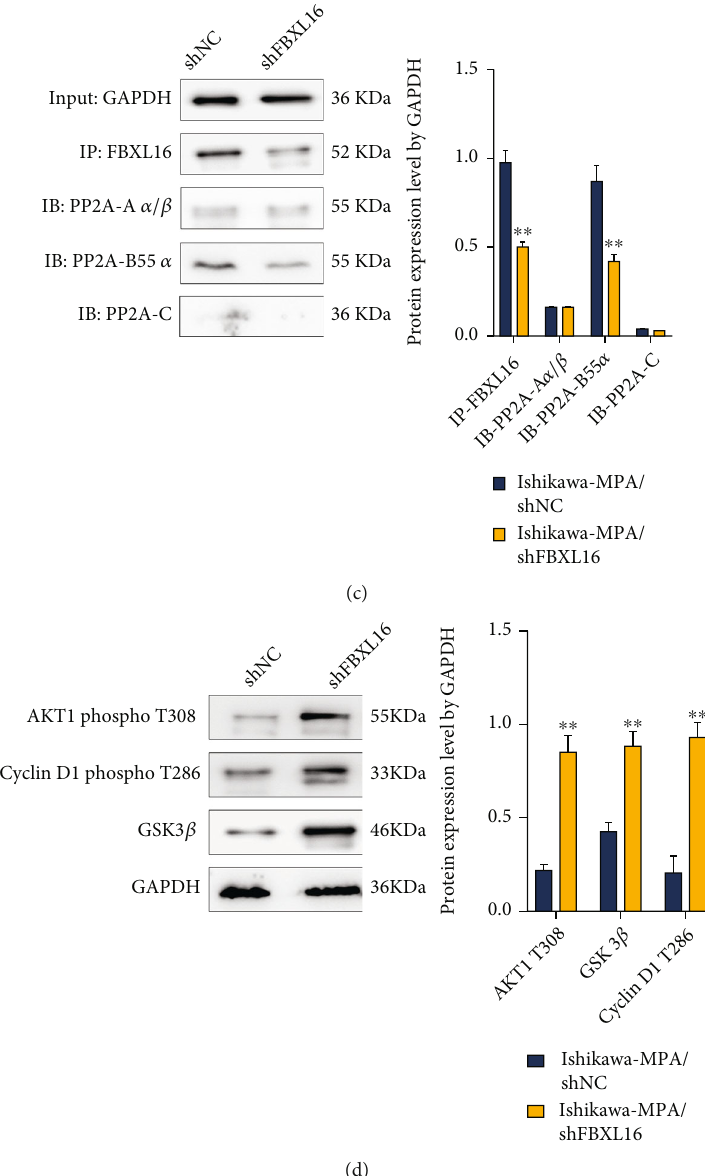
Figure 4: FBXL16 dephosphorylated cyclin D1 by regulating Akt1/GSK-3 β signaling pathway via binding PP2A B55 α . (a) Western blot analyses of cyclin D1 and phosphor-cyclin D1 (T286) in Ishikawa/MPA with shNC and shFBXL16 cells. (b) Coimmunoprecipitation of E3 ligase and cyclin D1 in Ishikawa/MPA cells with the shRNA-NC or shFBXL16 group. (c) Coimmunoprecipitation of FBXL16, PP2A-A α / β , PP2A-B55 α , and PP2A-C in Ishikawa/MPA cells with the shRNA-NC or shFBXL16 group. (d) Western blot analyses of phosphor-cyclin D1 (T286) and GSK3 β /AKT1 pathway in Ishikawa/MPA with shNC and shFBXL16 cells. Results are presented as mean ± SD . ∗ P < 0 : 05 . ∗∗ P < 0 : 01 . ∗∗∗ P < 0 : 001